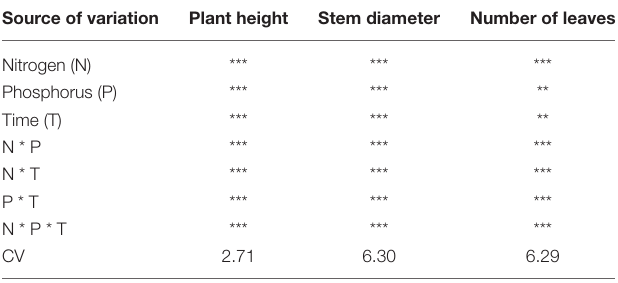
TABLE 2 | Analysis of variance (ANOVA) for plant height, stem diameter and number of leaves. Source of variation Plant height Stem diameter